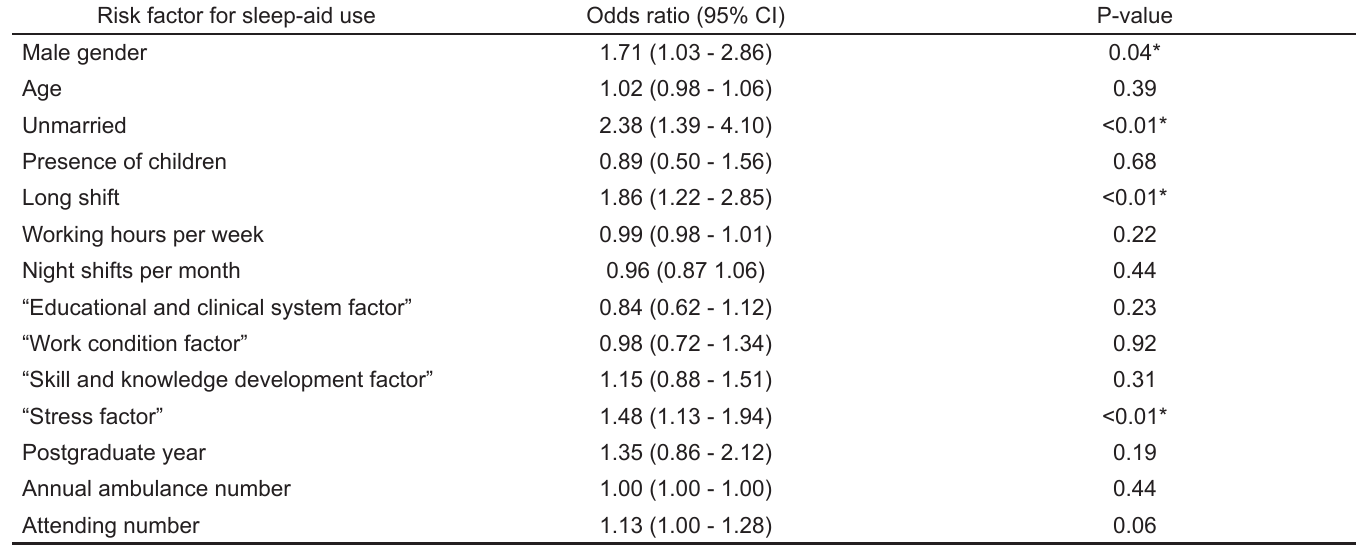
Table 5. Multivariable logistic regression analysis for sleep-aid